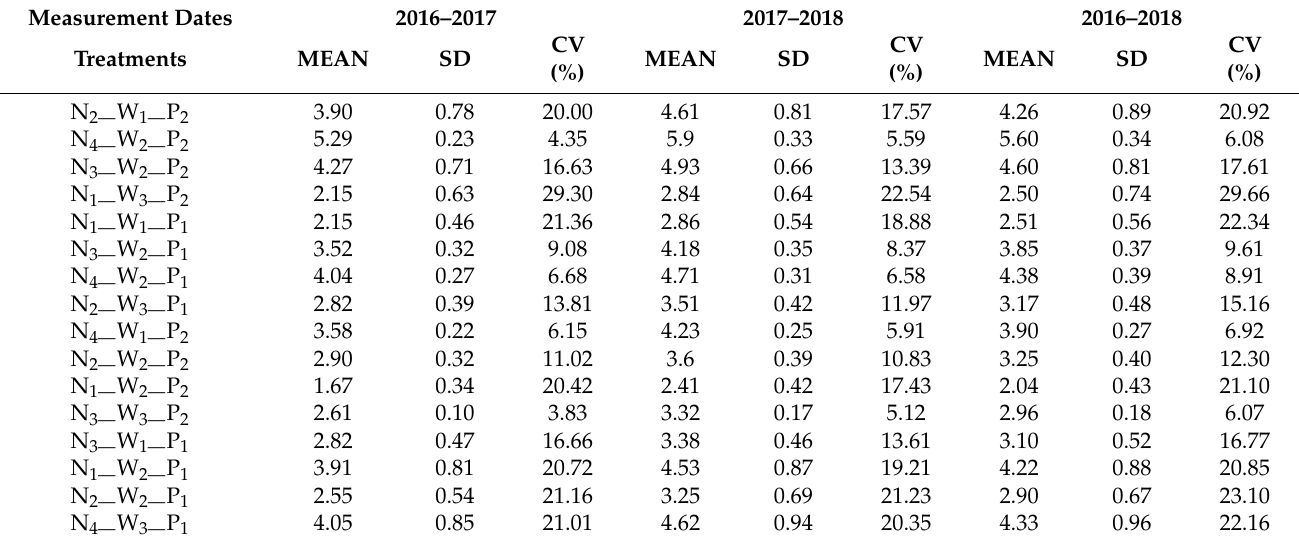
Table A4. Main statistical parameters of LAI at the flagging stage under different treatments.